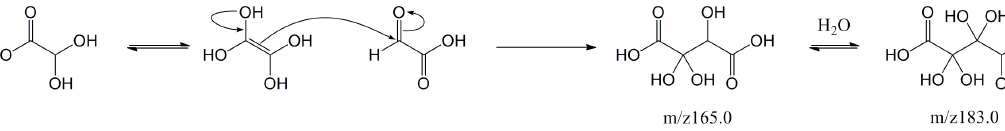
Fig. 8. Possible reaction schemes for the generation of the observed hydrate series with masses at m/z 165.0 and